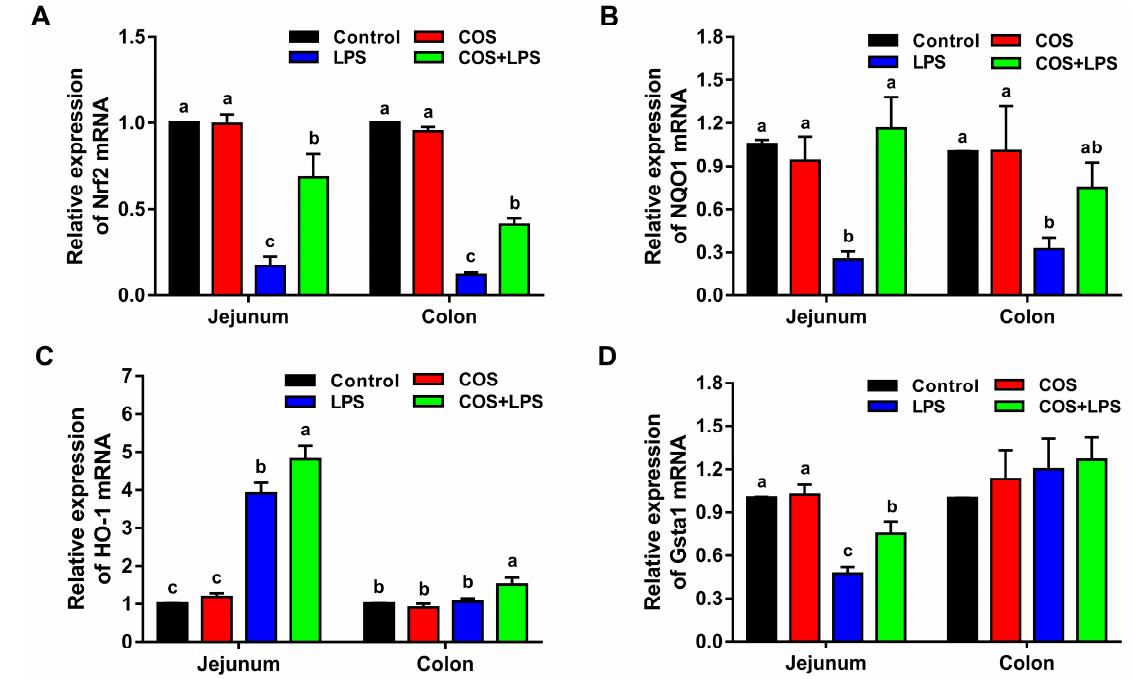
Figure 8. Effects of COS on mRNA expression of genes related to the antioxidant capacity in the jejunum and colon of mice. The relative mRNA expression of Nrf2 ( A ), NQO1 ( B ), HO-1 ( C ) and Gsta1 ( D ) in the jejunum and colon. The data are presented as the mean ± SE ( n = 6). Values without a common letter are significantly different ( p < 0.05). COS, chitosan oligosaccharide; LPS, Lipopoly-